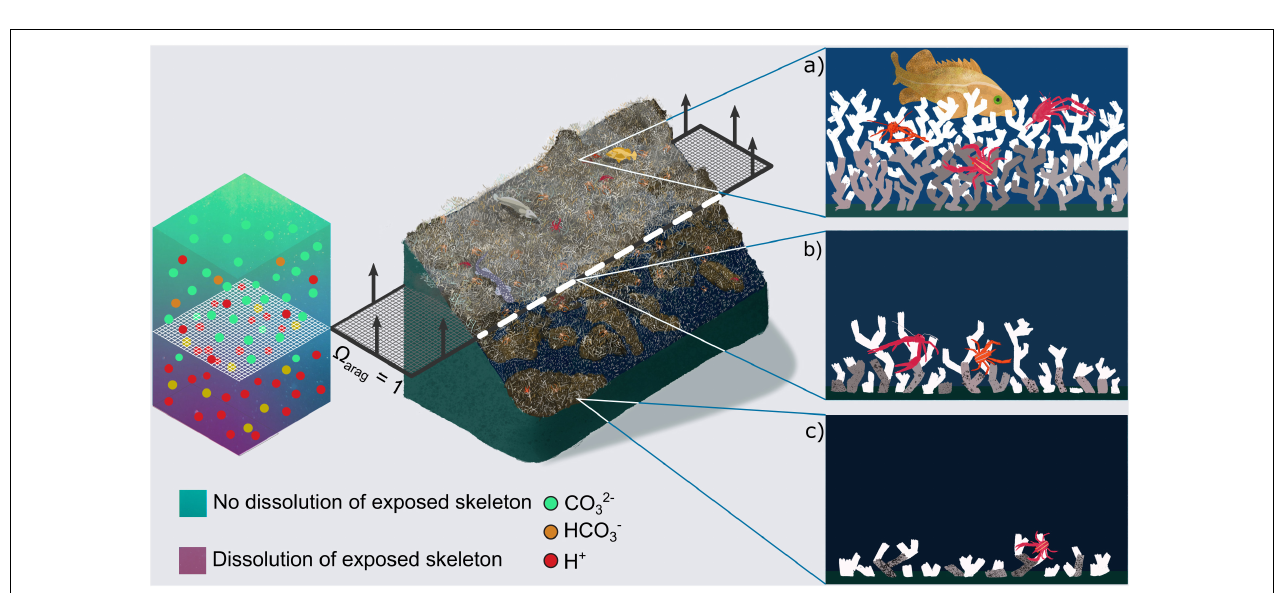
FIGURE 2 | Concept of cold-water coral habitat loss in a future ocean. Central image shows Lophelia pertusa reefs under present day conditions (top), and their projected habitat loss in a future ocean, once the aragonite saturation horizon (ASH, dashed layer at (cid:127) Arag = 1) rises above them. A qualitative chemistry scale bar indicates dissolution of exposed aragonite beneath the horizon driven by increased [H + ] and decreased [CO 32 - ] ions. Arrows on the dashed layer indicate projected direction of ASH movement driven by ocean acidification. Panels on the right zoom into areas of present day and future reefs related to the position of the ASH. (a) Shows a healthy reef with substantial live (white) and dead (grey) coral framework ( Figure 1a ). In (b) porosity has started to appear in the dead, exposed skeletal framework leading to crumbling. In (c) exposed skeletal framework exhibits large porosity and is unable to support complex 3D habitat, although high abundances of live coral can still exist ( Figure 1b